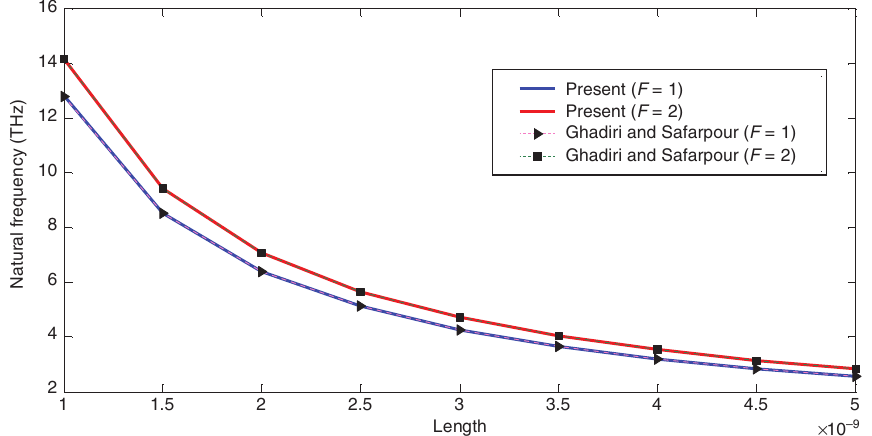
Figure 2: Comparison of the natural frequency of FG cylindrical shell with the results obtained by Ghadiri and Safarpour